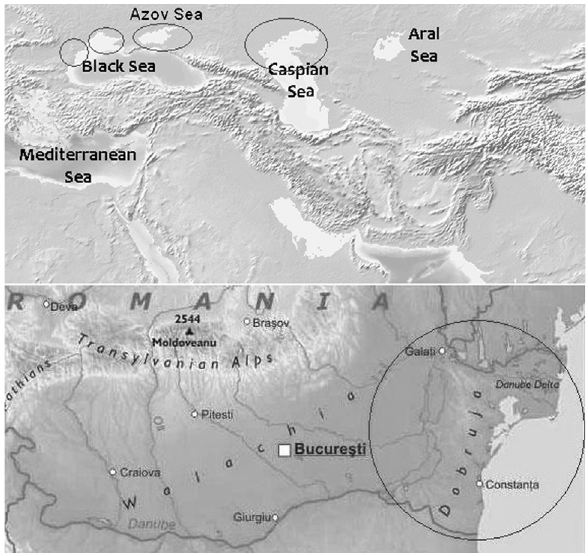
Figure 1 - Sampling region for Romania and the provenance of samples obtained from